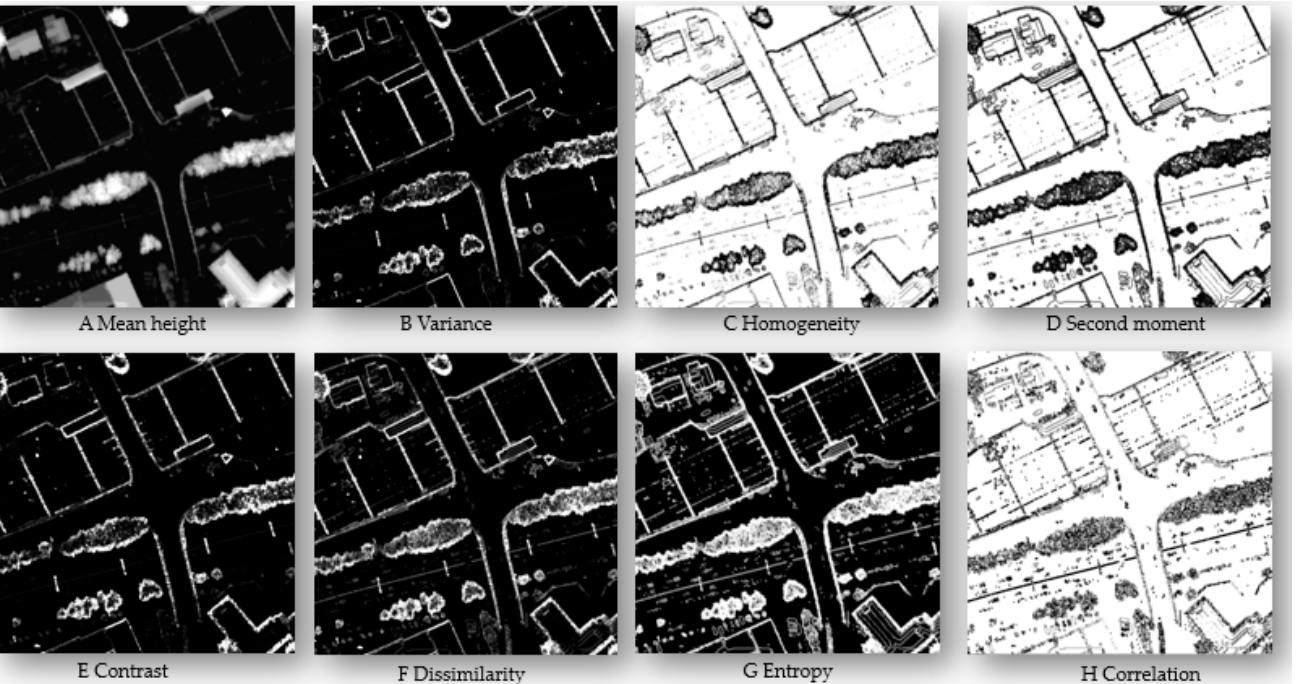
Figure 4. Features derived from the height information from lidar data.